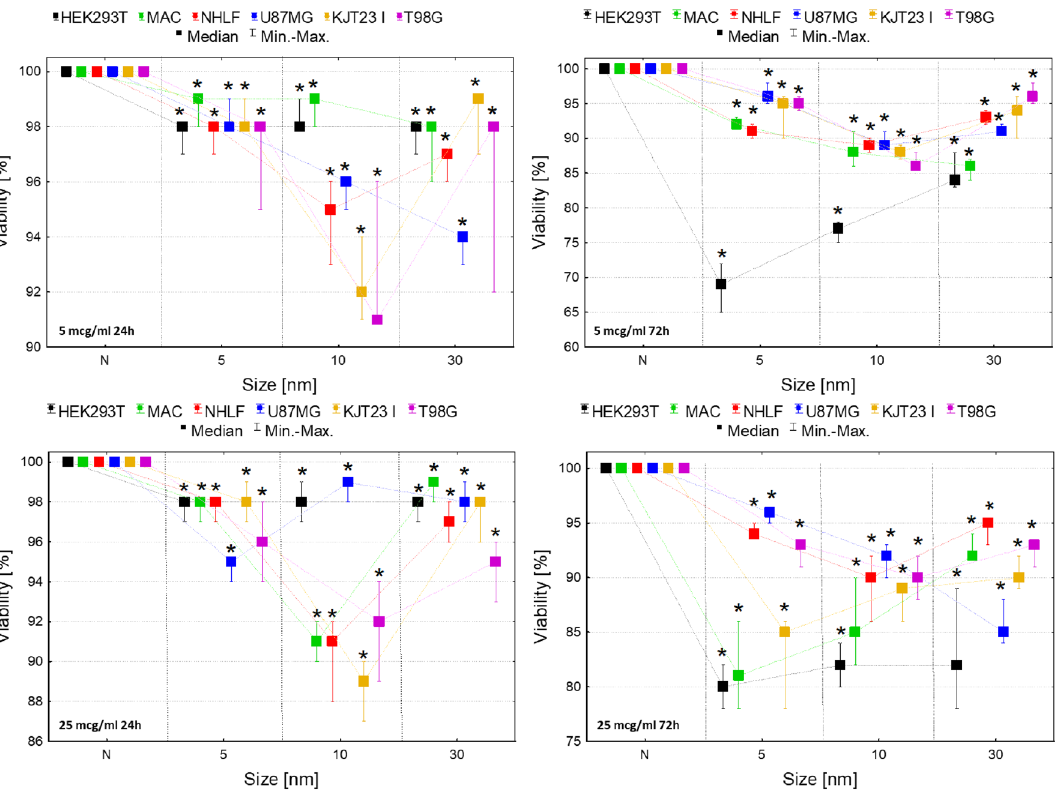
Figure 2. Normalized cell viability after 24 and 72-h exposure to IONPs with core diameter of 5 nm, 10 nm and 30 nm in the concentrations of 5 µg Fe/ml and 25 µg Fe/ml comparing to the control groups (N). The statistically significant ( p < 0.05) decreases of cells viability compared with corresponding N group were marked with “*”. The scales were adjusted for each chart so that data presented are the most